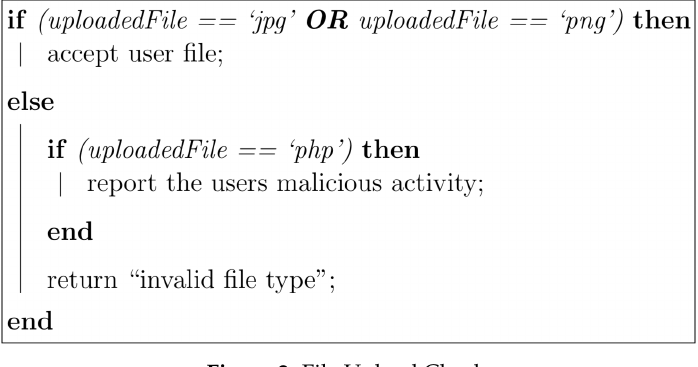
Figure 2. File Upload